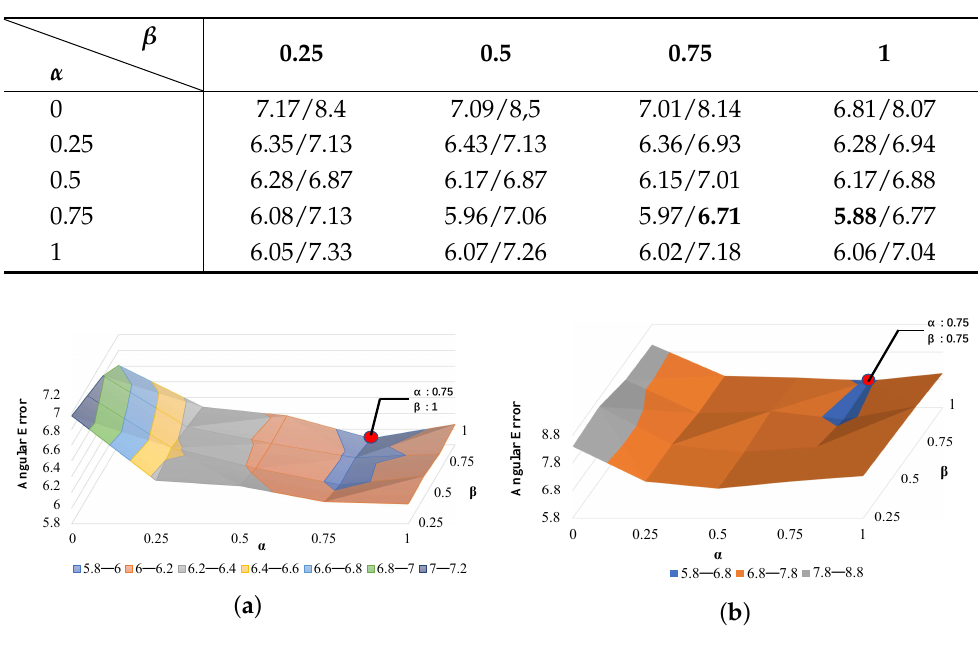
Figure 11. Surface plots the angular-error in function with α and β using MpiiGaze ( a ) and Eyediap ( b ). The red dot represents the best performance.